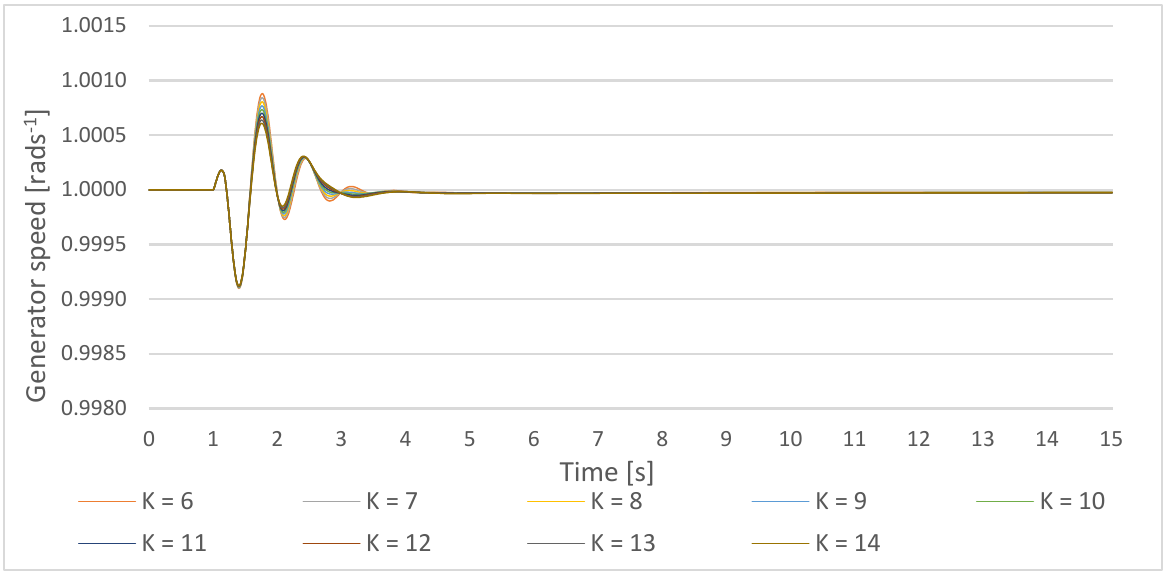
Figure 23. Gen1 rotor angle response on a small disturbance with PSS parameters T = 0.5 s, the PSS gain increase in the lower cluster 1-K i,ln = 6 – 10, and the upper cluster 1 K i,um = 10 – 14.